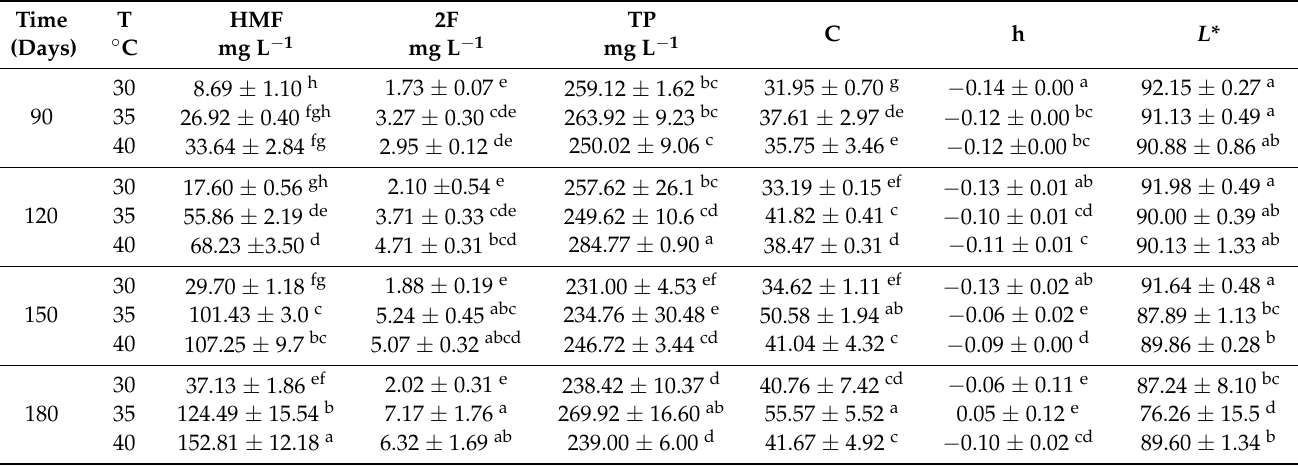
Table 5. Evolution of quality parameters of MdL wine samples at different storage temperatures (30, 35, 40 ◦ C) (HMF: 5-hydroxymethylfurfural; 2F: 2-furaldehyde; TP: total phenols; C: chroma; h: hue; L *: lightness) from 90 to 180